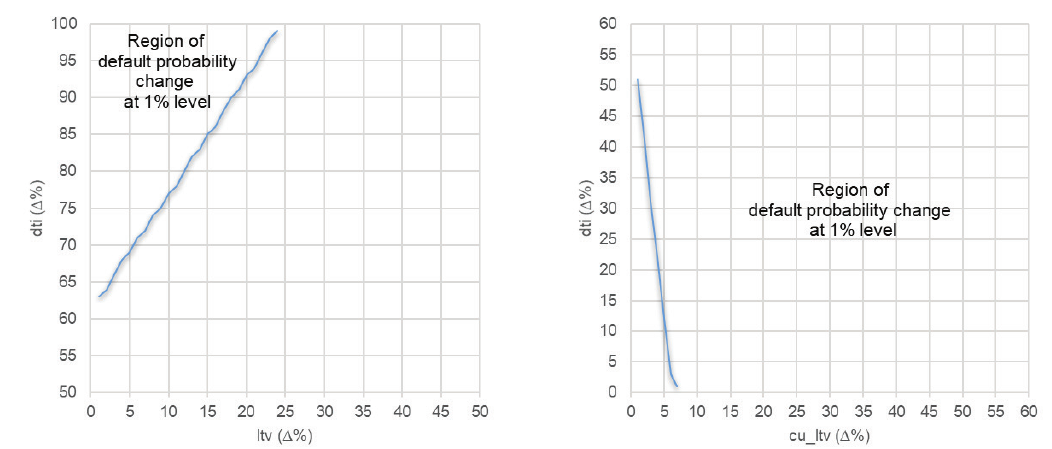
Figure 1. Change in ME resulting from a change in the original DTI (dti), and either original LTV (ltv) or current LTV (cu_ltv) in the ANN model at the 1% signifi cance